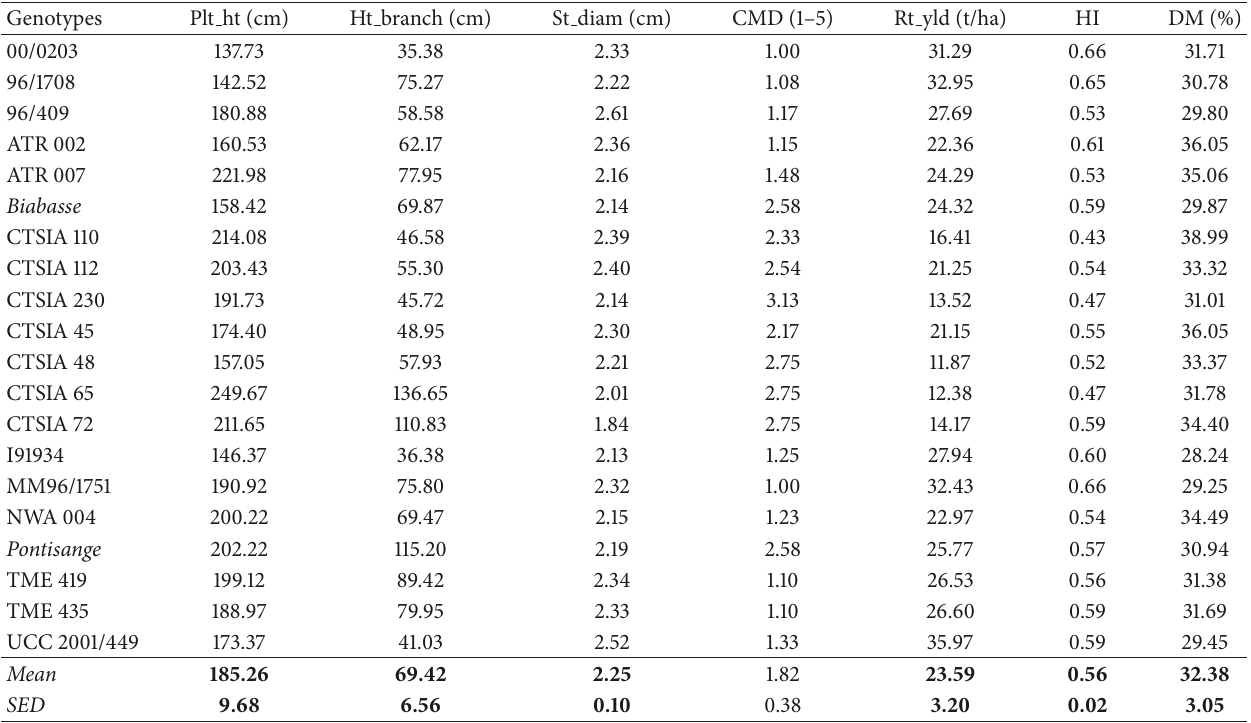
Table 6: Mean performance of 20 cassava genotypes evaluated in four environments.